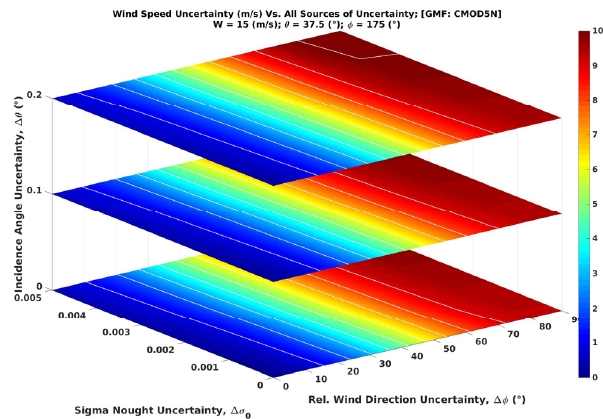
Figure 4. The CMOD5.N-derived SAR SSW speed uncertainty ∆ W max (m/s), due to both the fixed true state (W, θ , ϕ ) = (15 m/s, 37.5 ◦ , 175 ◦ ) and the varying triplet of uncertainties ( ∆ σ 0 , ∆ θ , ∆ ϕ ), respectively in the range [0, 0.005] ( y axis), [0 ◦ , 0.2 ◦ ] (with a step of 0.1 ◦ ) ( z axis) and [0 ◦ , 90 ◦ ] ( x axis).